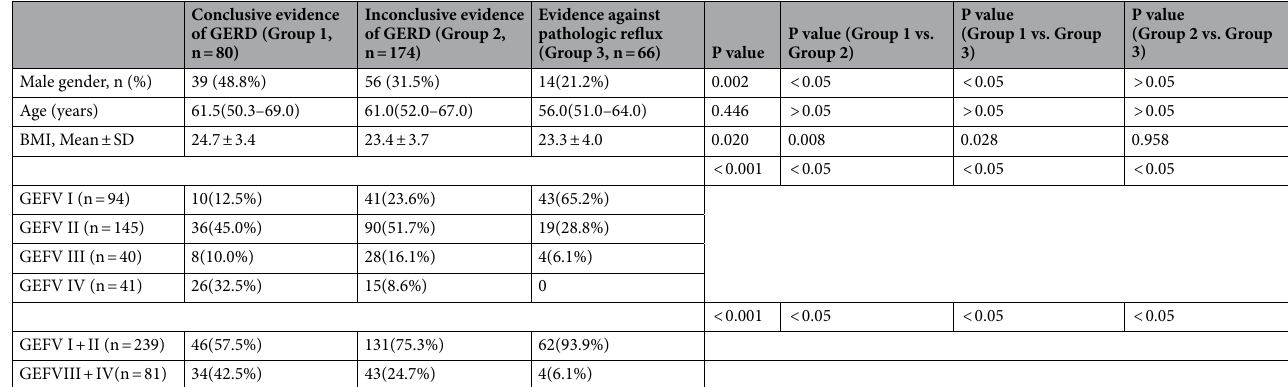
Table 1. Demographic and clinical characteristics of 320 patients with GERD symptoms according to the lyon consensus. Values are presented as the median and interquartile range for age, means and standard deviation for BMI, and n (%) for male gender and GEFV grades. GERD gastroesophageal reflux disease, BMI body mass index, GEFV gastroesophageal flap valve. The difference was significant when P <